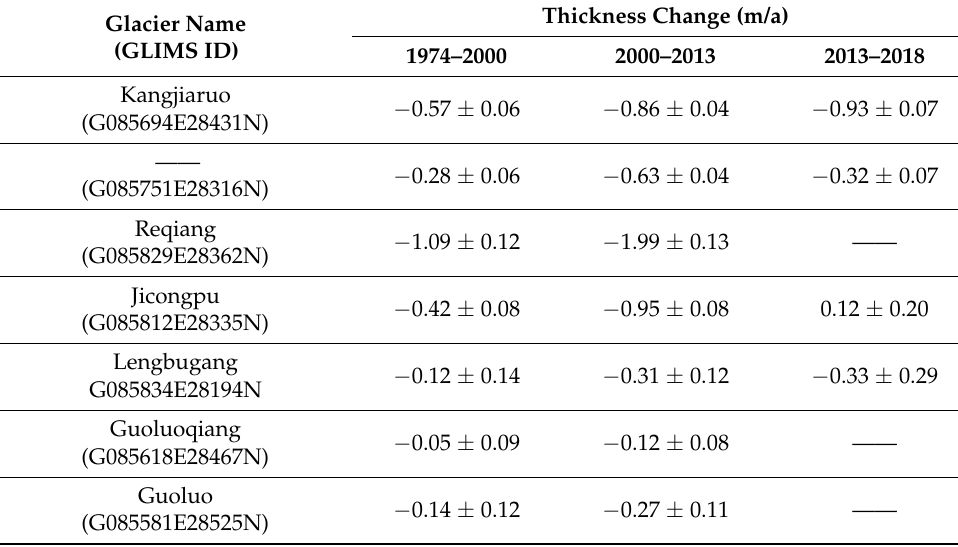
Table 5. Measured thickness changes in seven glaciers in the Xixabangma